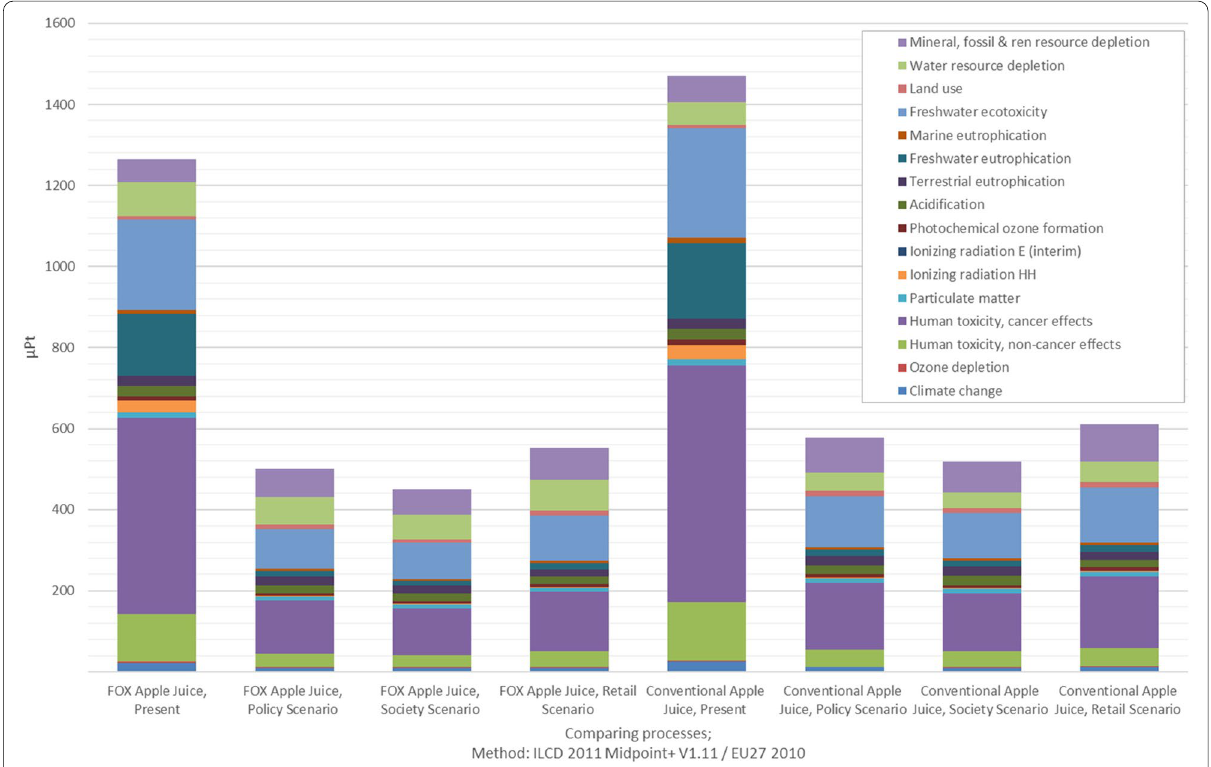
Fig. 5 Results of the impact assessment presented as a single score for the FOX and conventional apple juice in the present and three future scenarios, respectively; weighted factors, method: ILCD 2011 Midpoint +